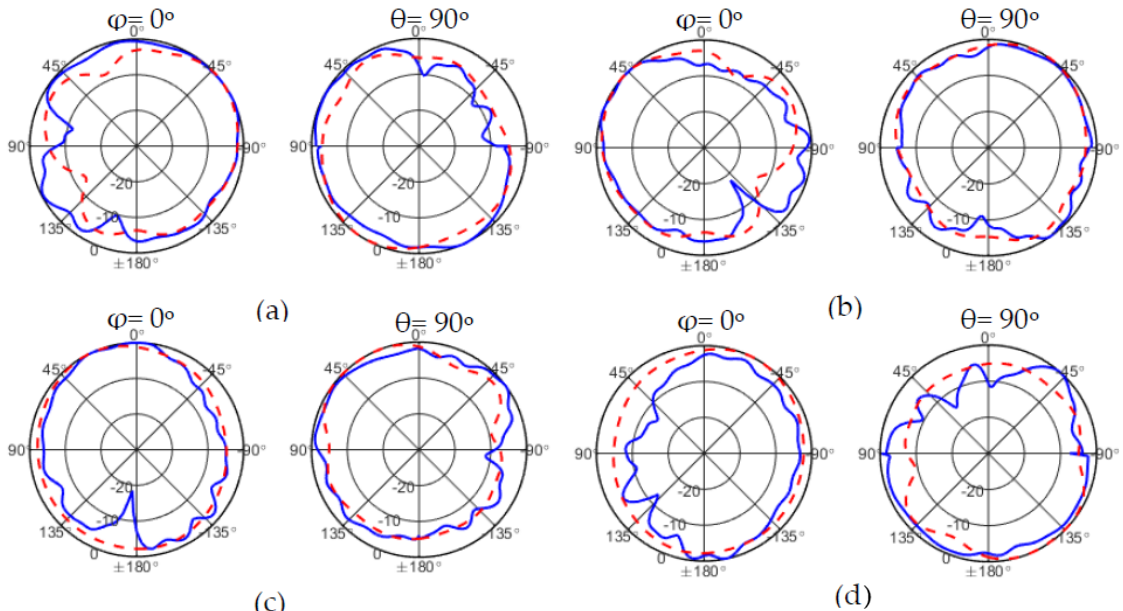
Figure 8. The simulated and measured 2D radiation patterns in terms of gain at 3.6 GHz: ( a ) Ant. 1, ( b ) Ant. 4, ( c ) Ant. 2, and ( d ) Ant. 3. Simulated: dashed red curves; measured: solid blue curves.